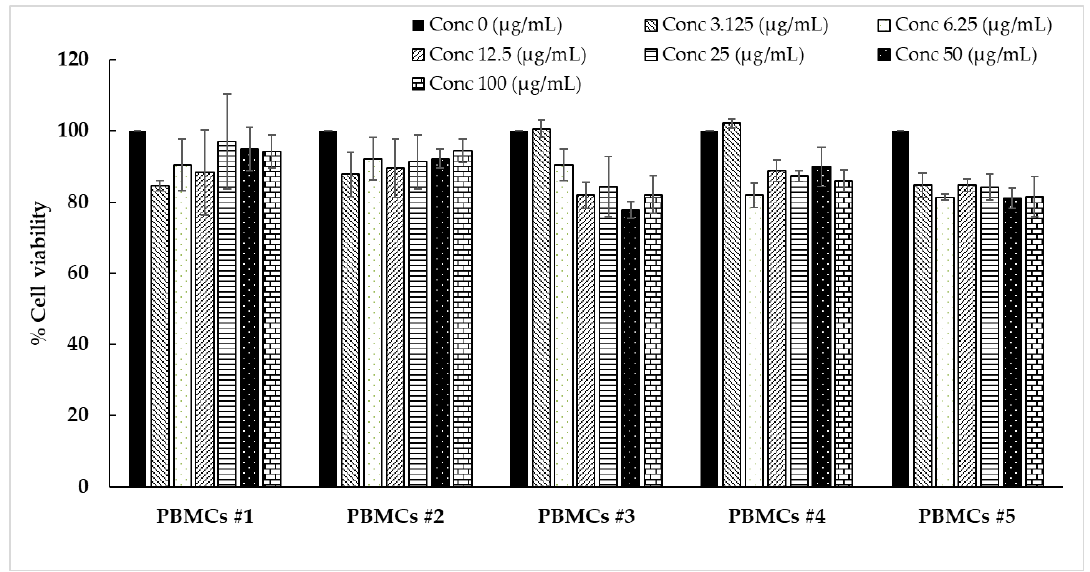
Figure 3. Effect of antler-type G. lucidum BG at various concentrations on cell viability of peripheral blood mononuclear cell (PBMC) from 5 healthy volunteers (#1 – #5). Data were expressed as Mean ± SD values from 3 replications.